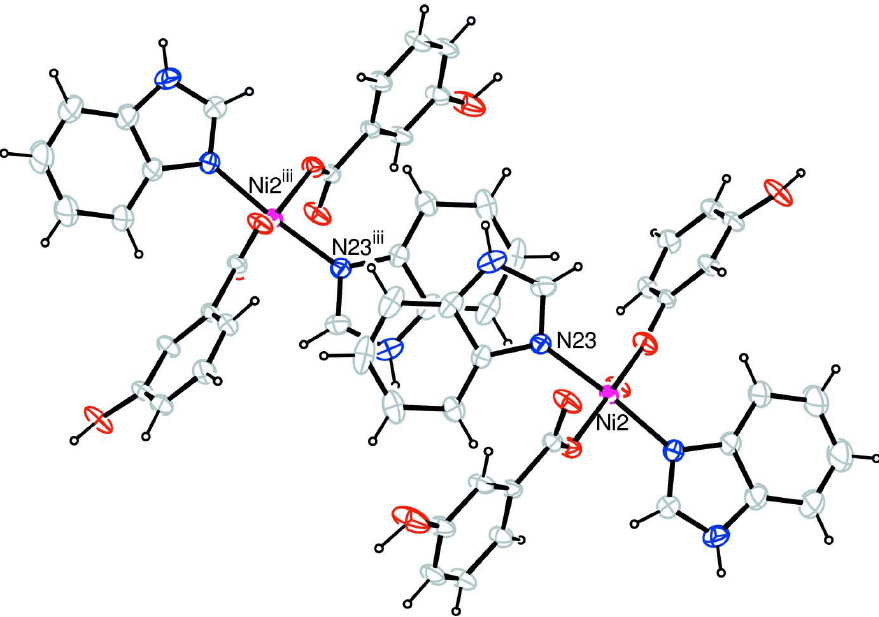
The molecular structure of the title compound with 30% probability displacement ellipsoids (arbitrary spheres for H atoms). Dashed lines indicate the hydrogen bonding [symmetry codes: (i) 2 - x ,1 - y ,- z ; (ii) 1 - x ,- y ,1 - z ].